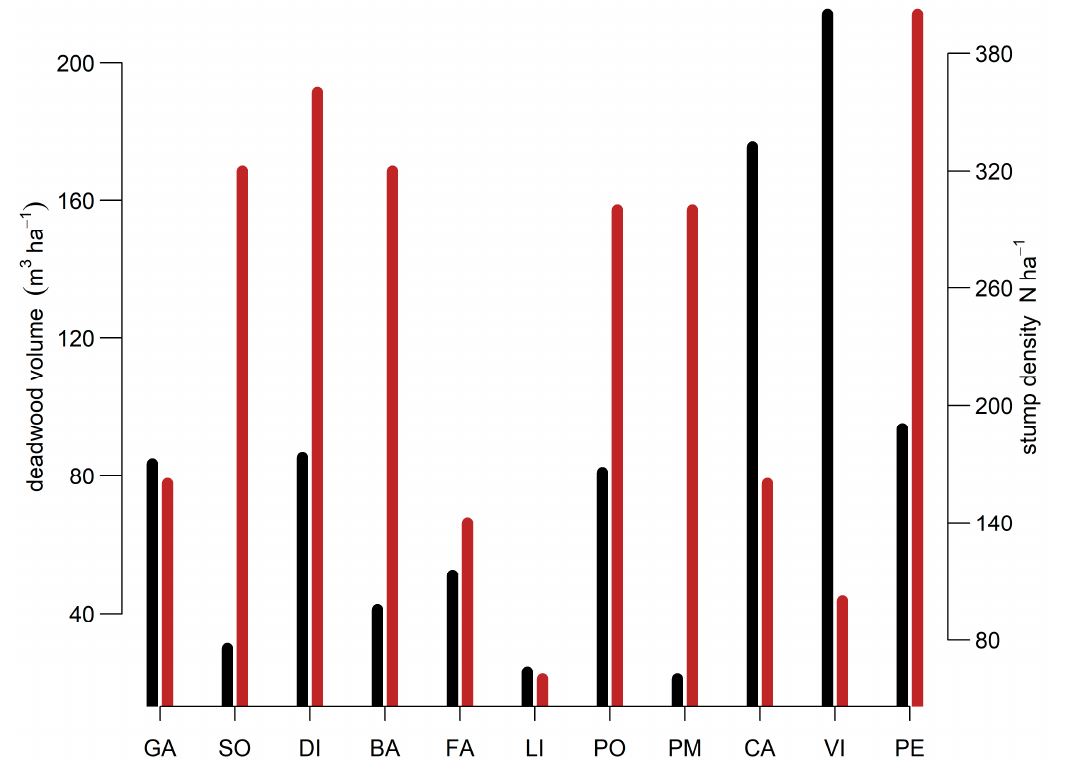
Figure 4. Distribution of deadwood volume (black bars) and the density of stumps and snags (brown bars) per site. Table 3. Characteristics of deadwood according to the degree of decomposition and basal area, and density of stumps. The site codes are as in Table 1. The presence of snags was recorded in each site, and the lying deadwood was classified according to the degree of decomposition, into five catego- ries (see Methods). In addition, the lying deadwood volume and cover were calculated using the line intercept method, and we also quantified the density and basal area of stumps, considering both silver fir as well as other species. The density and basal area and stumps were classified to the species level when possible due to the decomposition grade. Site